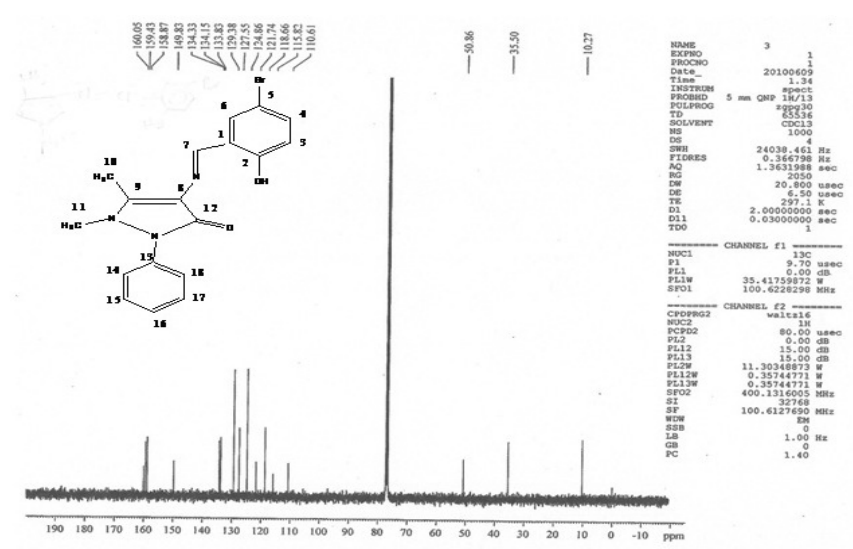
Figure 2. 13 C NMR spectra of 5-Br SALAAP